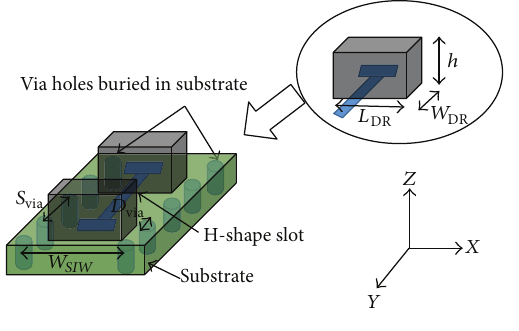
Figure 4: DR coupling through aperture.